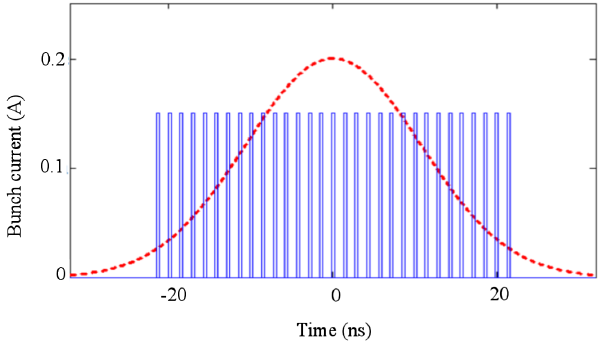
FIG. 4. The LEReC electron beam and RHIC ion beam time structure, showing the overlap of 30 to 36 electron bunches (blue) with a single gold ion bunch (red). The electron bunches are spaced by 1.4 nsec (704 MHz), with a charge of 0.13 nC and a length of 0.4 nsec. The gold ion bunch has a charge of 7.5 nC and a bunch repetition frequency of 9 MHz.